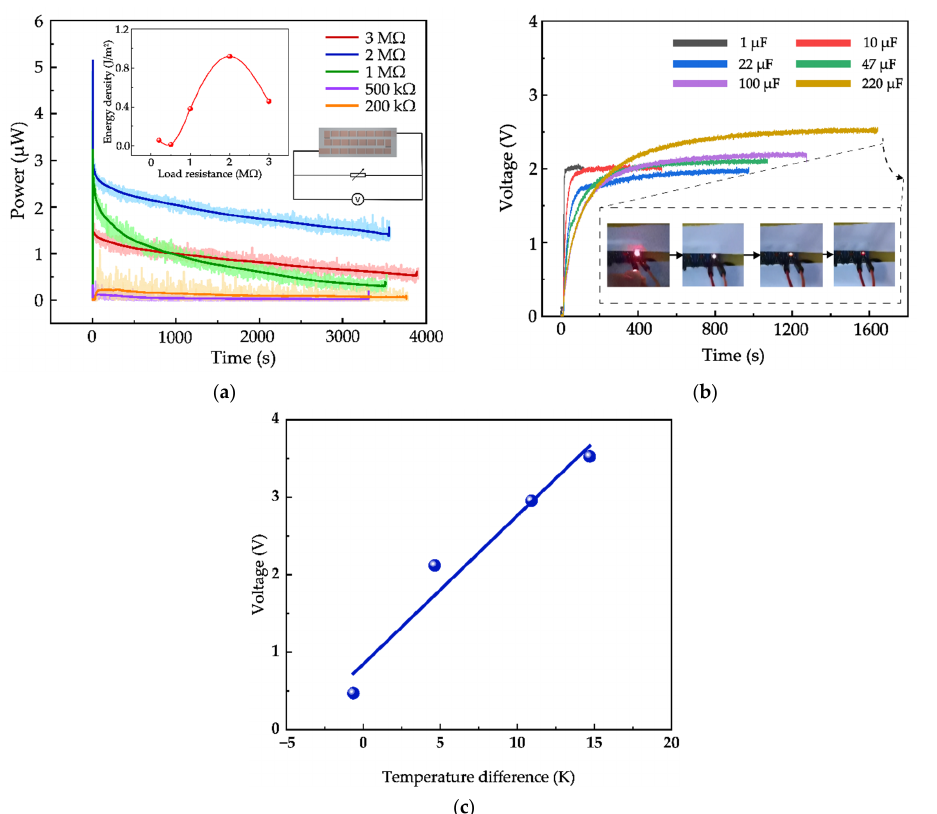
Figure 9. ( a ) The power curves of the STEG (insets are the output energy density curve of the STEG and the schematic diagram of the experimental circuit); ( b ) capacitor charging curves and the LED driving test; ( c ) the measured V OC – Δ T curve of the